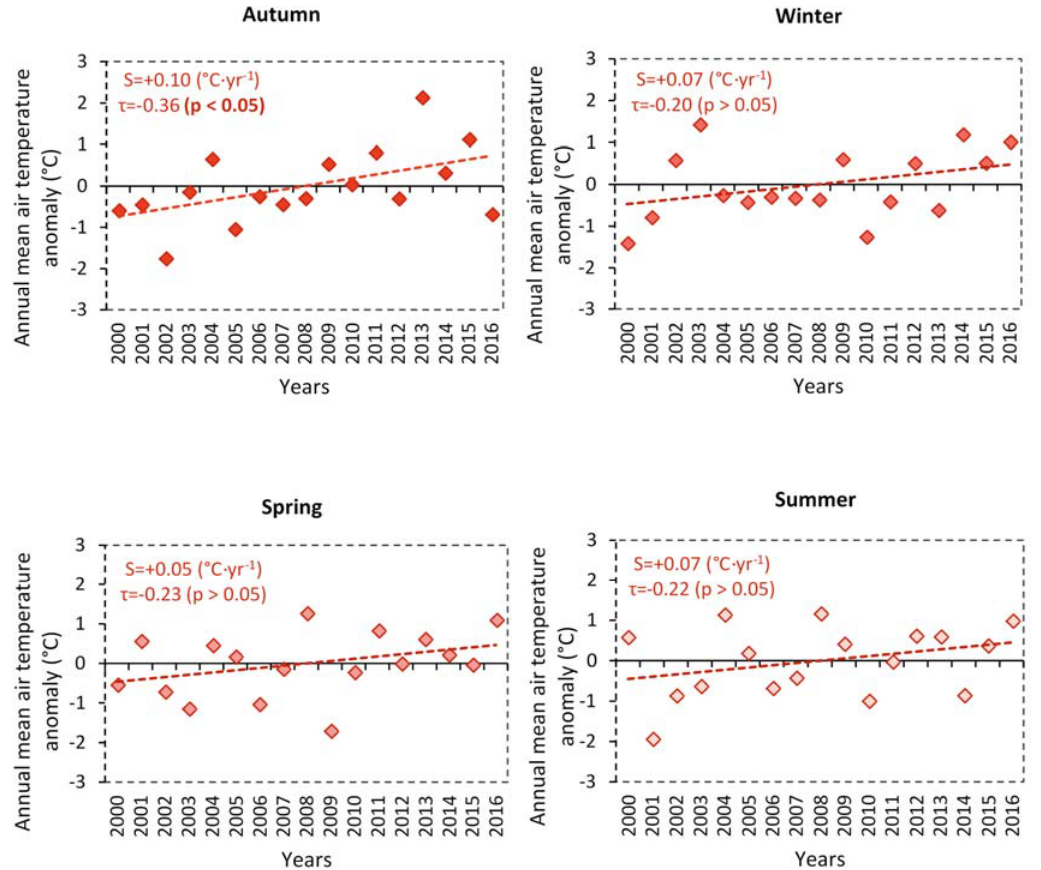
Figure 8. Anomalies of seasonal mean air temperature for the 2000–2016 period.